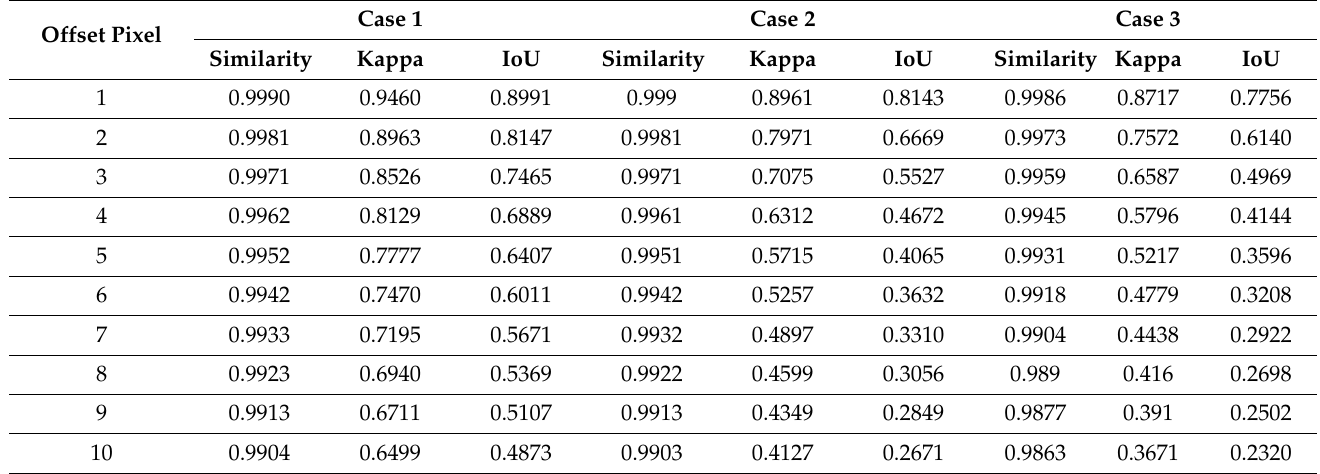
Figure 11. Line charts of three indicators changes with pixel offset.